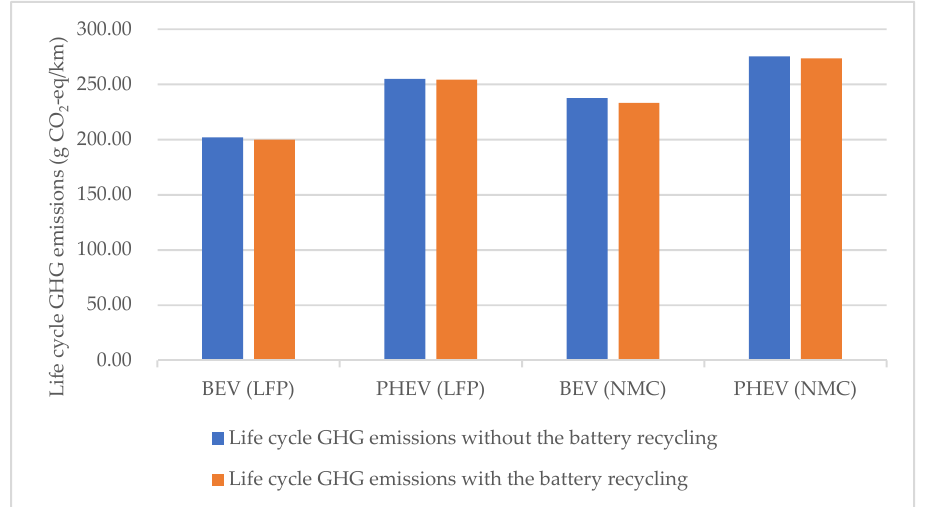
Figure 1. Life cycle GHG emissions with battery recycling. Figure 5. Life cycle GHG emissions with battery